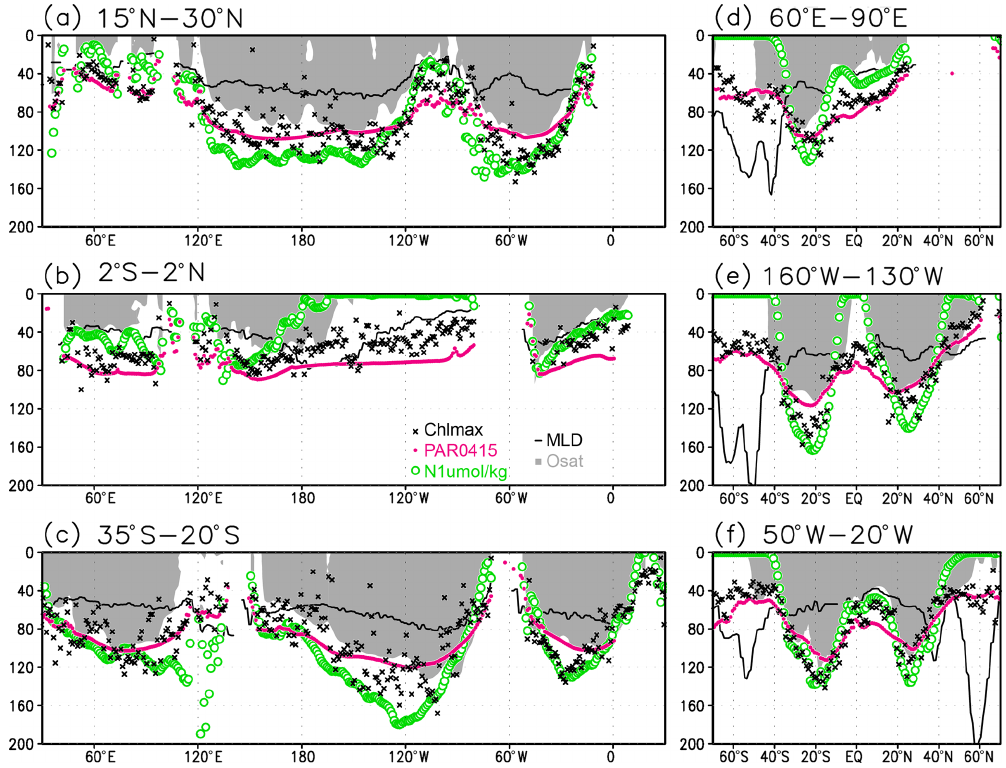
Figure 5. Depths of the chlorophyll a (Chl a ) maximum (black crosses), photosynthetically active layer ( > 0 . 415molm − 2 d − 1 of photo- synthetically available radiation; magenta dots), nitrate-depleted layer ( < 1µmolkg − 1 of nitrate; open green circles), mixed layer (black line), and oxygen-oversaturated layer (gray shading) at (a) 15–30 ◦ N (northern subtropics), (b) 2 ◦ S to 2 ◦ N (tropics), (c) 35–20 ◦ S (southern subtropics), (d) 60–90 ◦ E (Indian Ocean), (e) 160–130 ◦ W (Pacific Ocean), and (f) 50–20 ◦ W (Atlantic